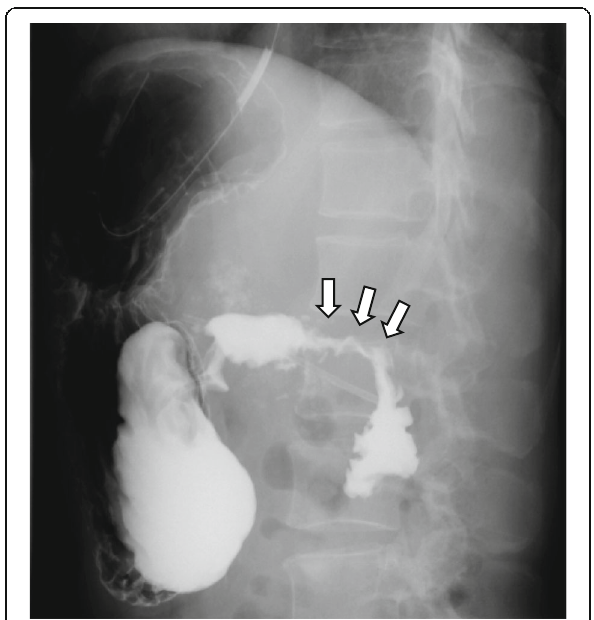
Fig. 1 Findings of upper gastrointestinal series. Standing, 2nd oblique position. The stenosis of the superior duodenal angulus of 4 cm length was revealed (white